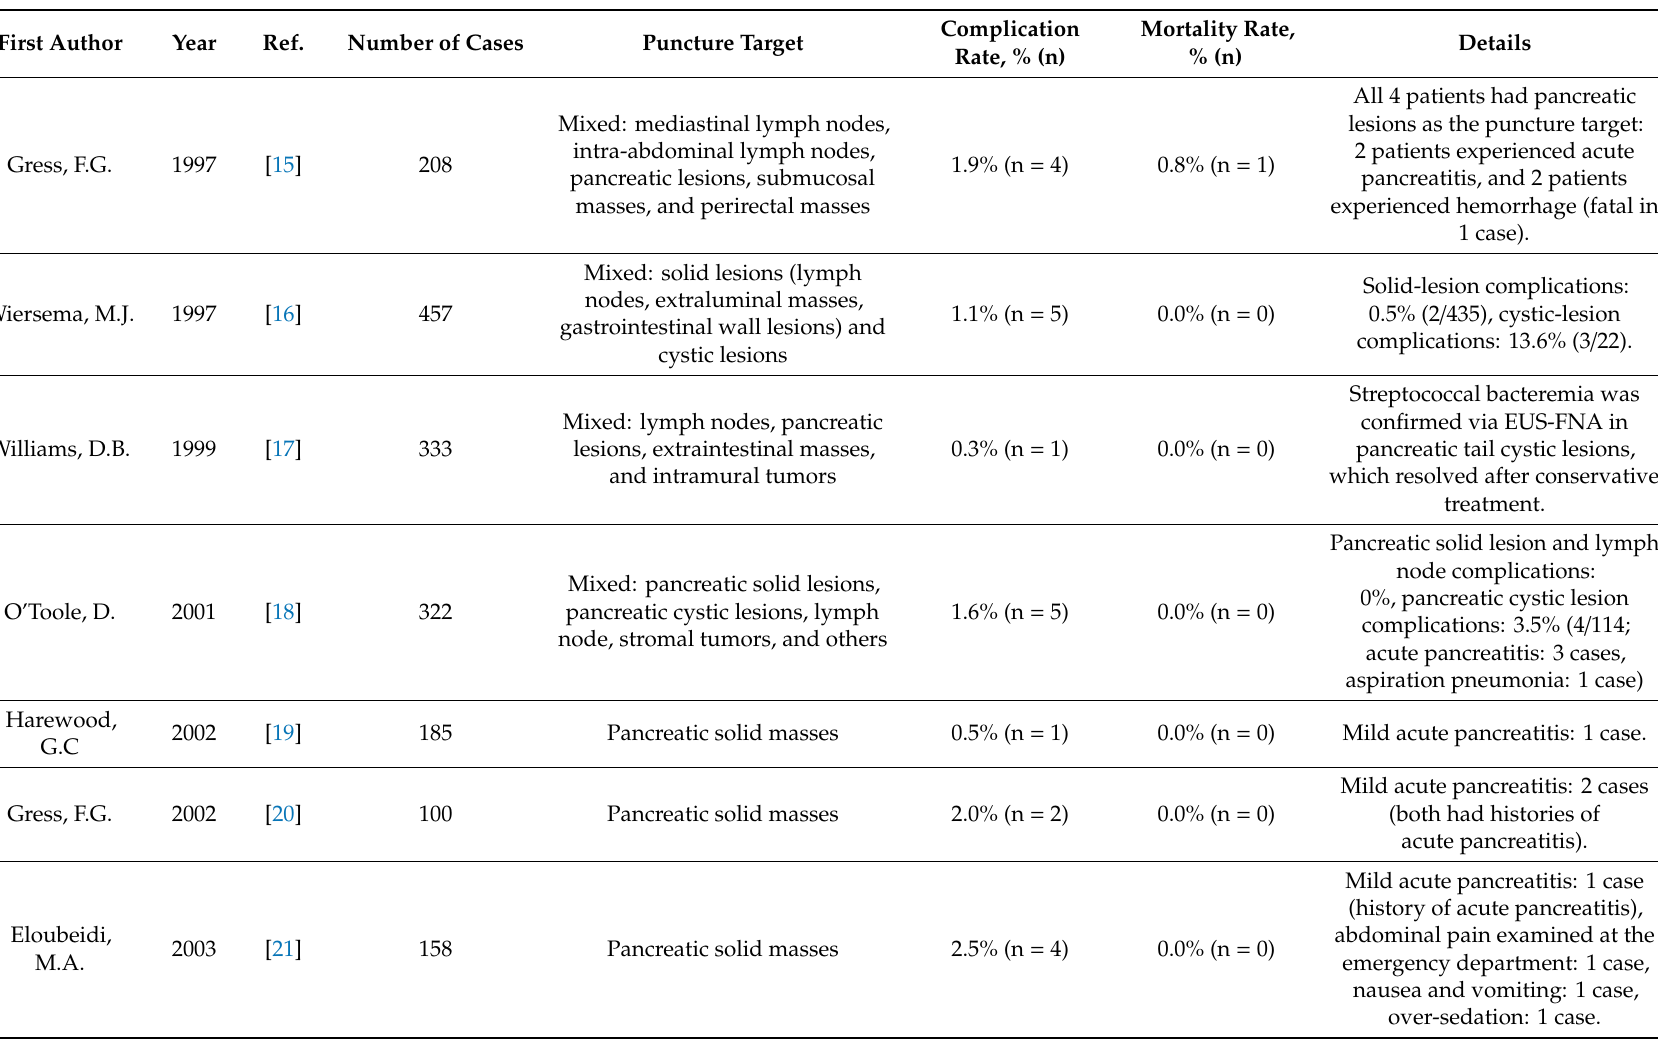
Table 1. An overview of the complications associated with endoscopic ultrasound-guided fine needle